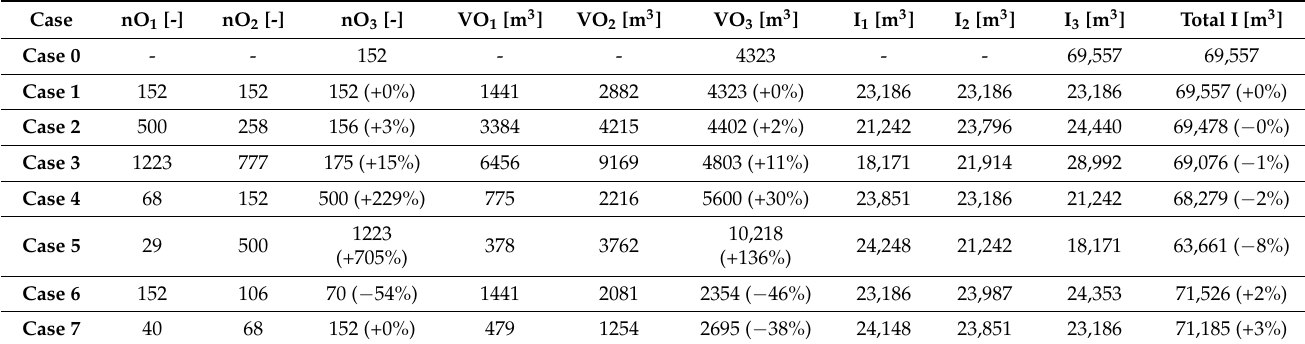
Table 2. Resulting performance metrics from the continuous simulations of the seven cases defined in Table 1. Percentage values in parenthesis express deviation from baseline (Case